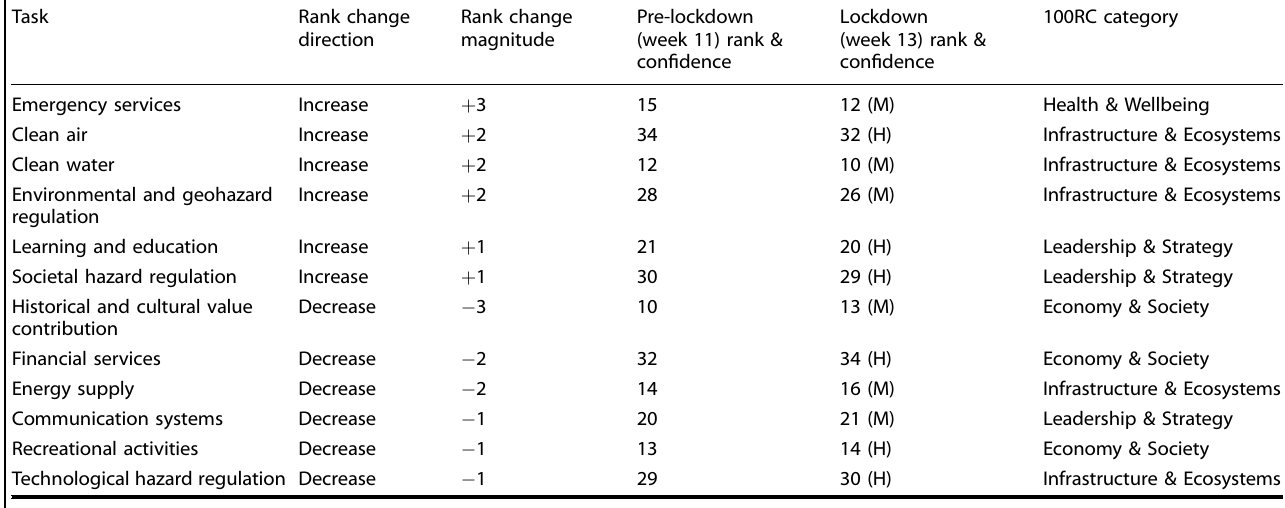
Table 4. Tasks which did not return to their week 10 (baseline) rank position in week 40.